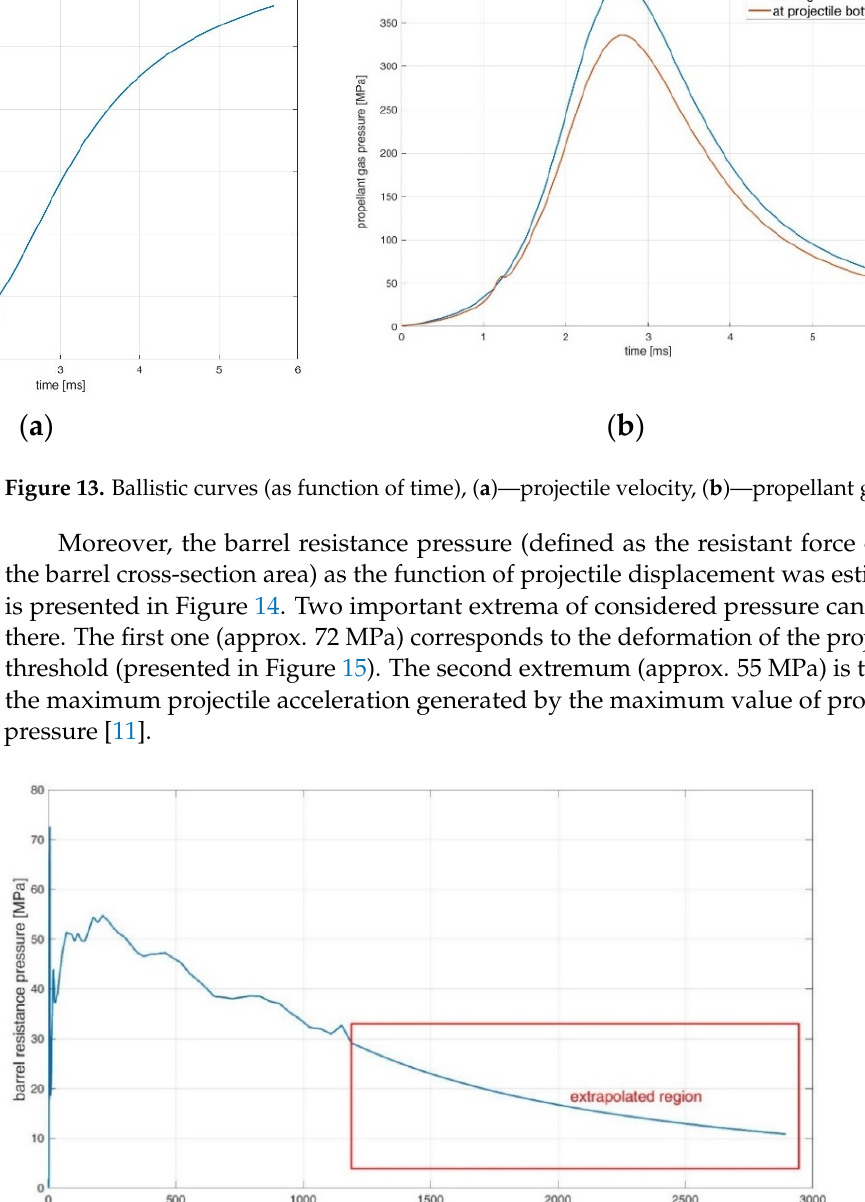
Figure 15. Shape of rotating band with projectile body threshold. Coupling of mechanical and thermal problems enabled estimation of the barrel inter- nal surface heat loading for two cross-sections. The first one corresponds to the cross-sec- tion which was investigated using a thermographic technique and characterized by the lowest heat capacity. On the other hand, the second one is the most thermally loaded cross-section close to the chamber and characterized by the largest heat capacity due to l the large barrel wall thickness. The courses of heat flux at the considered surfaces for the 6-round burst are presented in Figure 16. As can be seen, the gas-barrel heat transfer in- tensity decreases for each shot, which is the result of the barrel surface temperature in- crease during firing. The observed transferred heat value reduction coefficient (relative to the first shot), defined using the following formula: 1